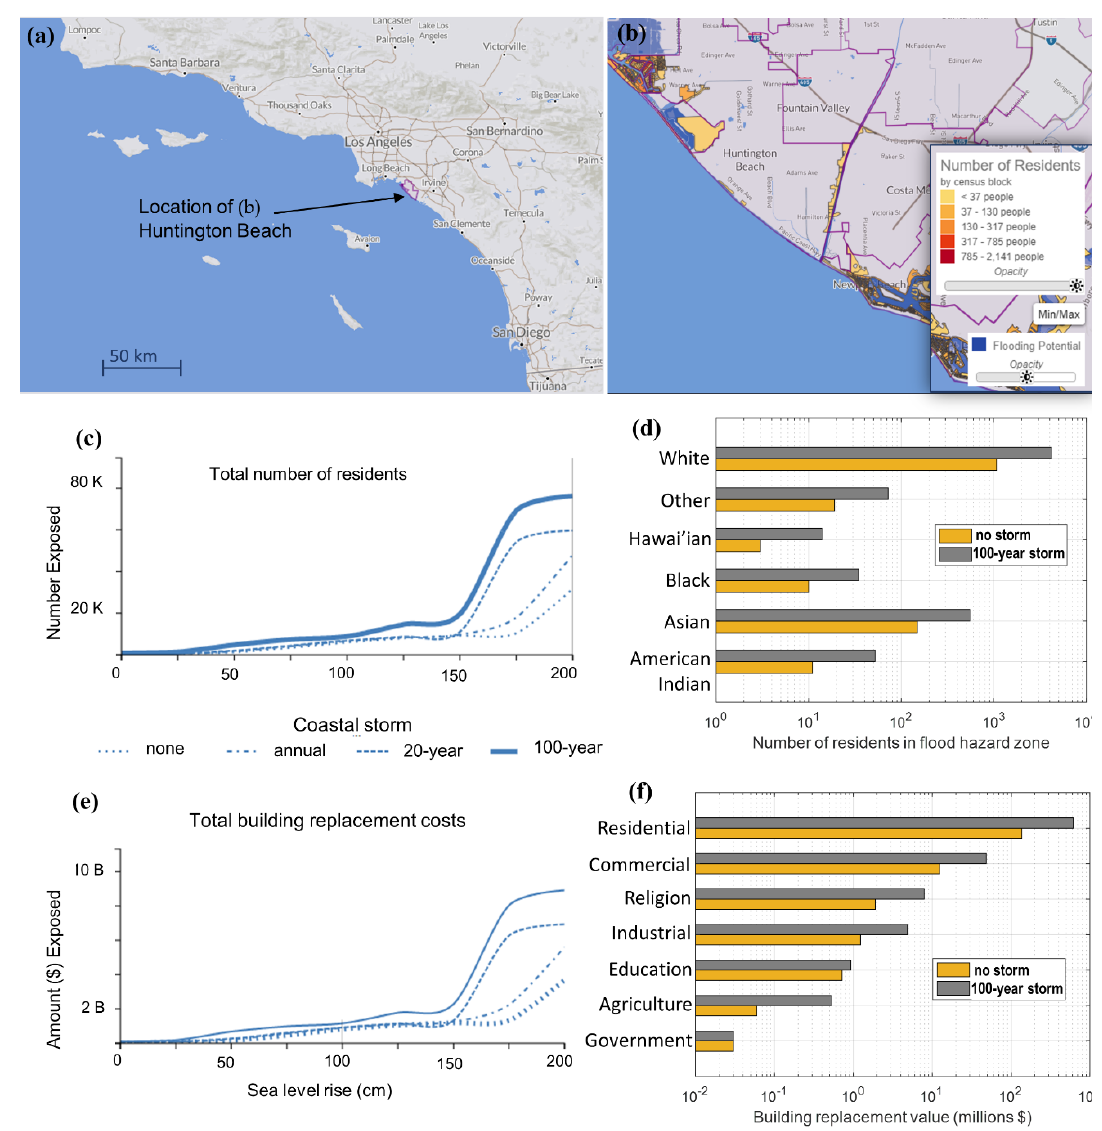
Figure 7. Example outputs from the Hazard Exposure and Analytics (HERA) web tool showing populations affected and building replacement costs within the Huntington Beach community in Orange County because of CoSMoS-modeled sea-level rise (SLR) and coastal storms. ( a ) Screen grab of HERA map showing Huntington Beach in Southern California; ( b ) Screen grab of spatial display in HERA showing the number of Huntington Beach residents exposed with 50 cm SLR in combination with a 100-year coastal storm (same as Figure 1b); ( c ) Total number of community residents exposed for all combinations of SLR (up through the 200 cm SLR) and coastal storms; ( d ) The number of community residents, grouped by ethnicity, exposed to the 50 cm SLR inclusive and exclusive of the 100-year storm; ( e ) Total building replacement costs within the community for all combinations of SLR (up through the 200 cm SLR) and coastal storms; ( f ) Building replacement costs, grouped by occupancy class, exposed to the 50 cm SLR inclusive and exclusive of the 100-year